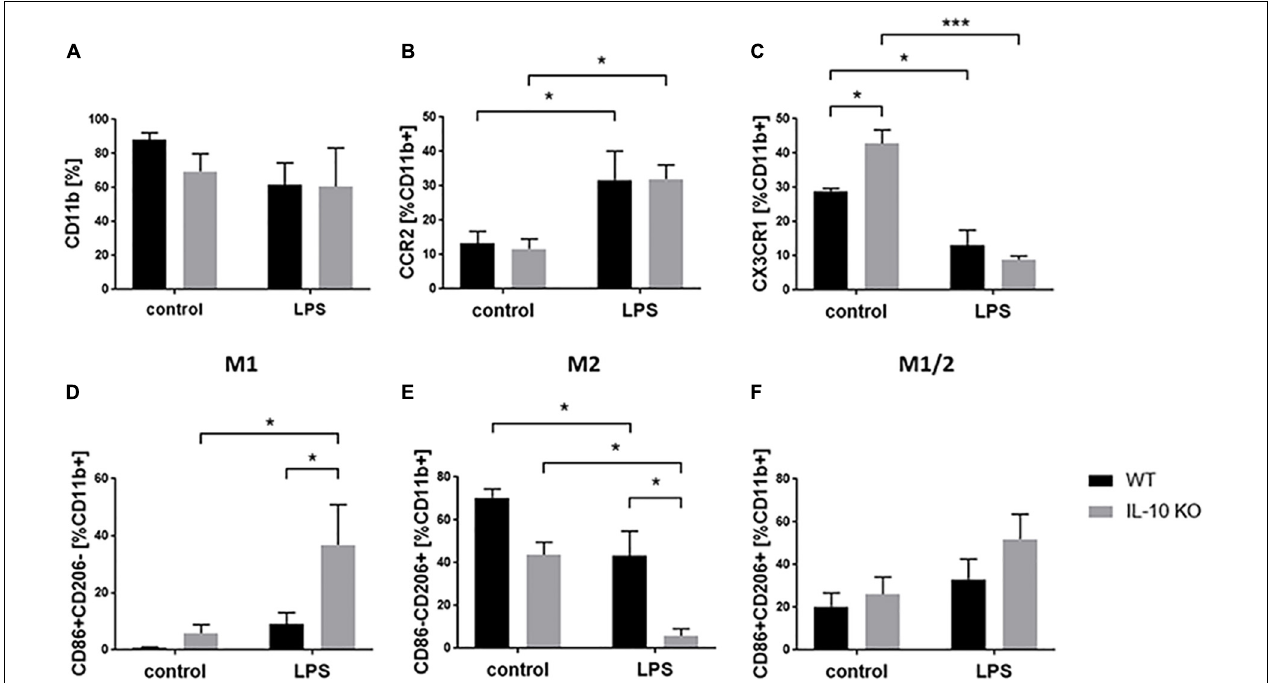
FIGURE 4 | Flow cytometry of WT (black bars) and IL-10 KO (gray bars) microglia of control group or after LPS treatment. Data in% of CD11b+ cells, (A) CD11b, (B) CCR2, (C) CX3CR1, (D) M1 CD86+ CD206–, (E) M2 CD86-CD206+, (F) M1/2 CD86+ CD206+ ( N = 3), mean ± SEM. One-way ANOVA, ∗ p < 0.05; ∗∗∗ p <